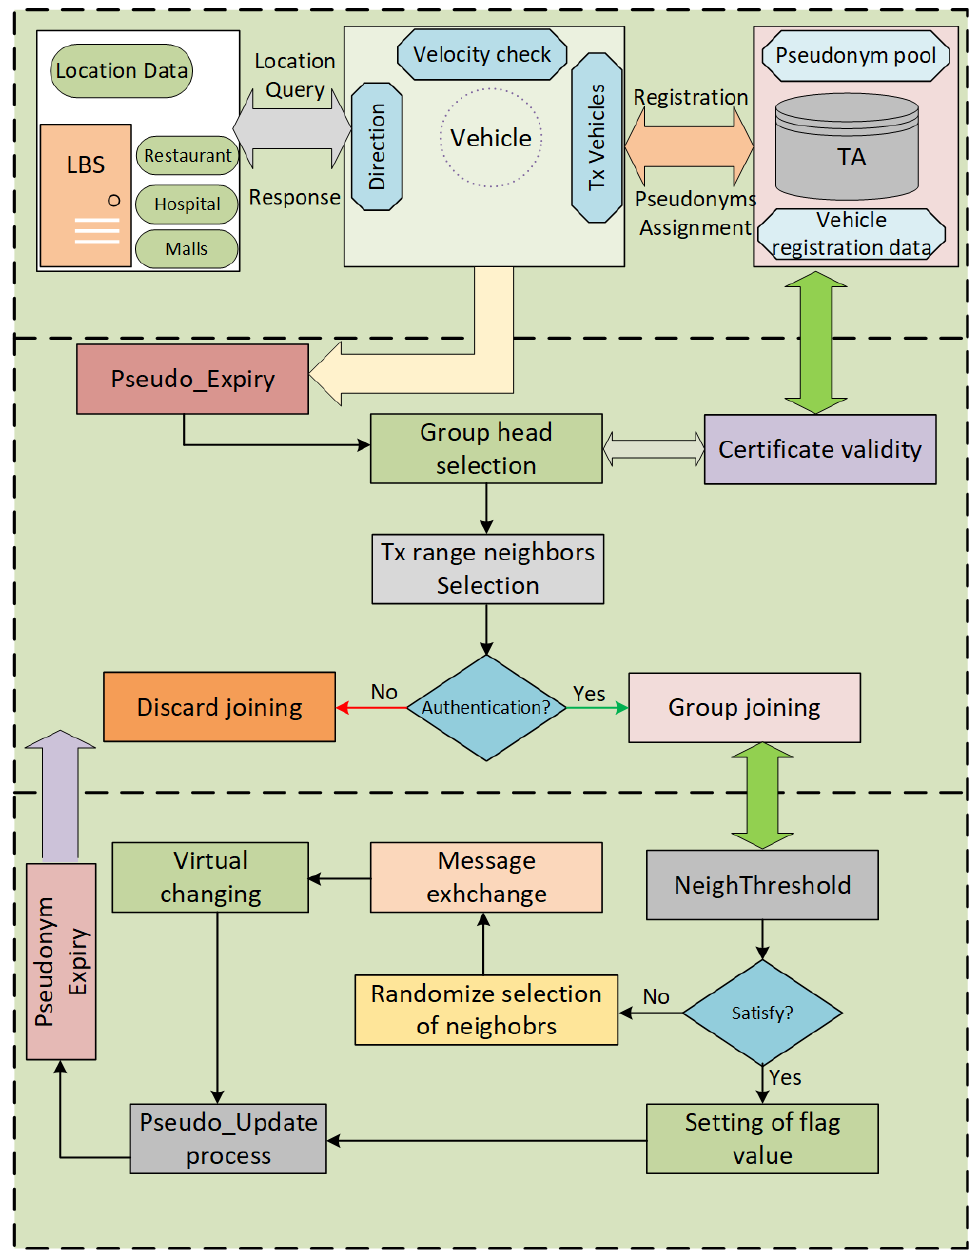
Figure 4. The block diagram of the proposed